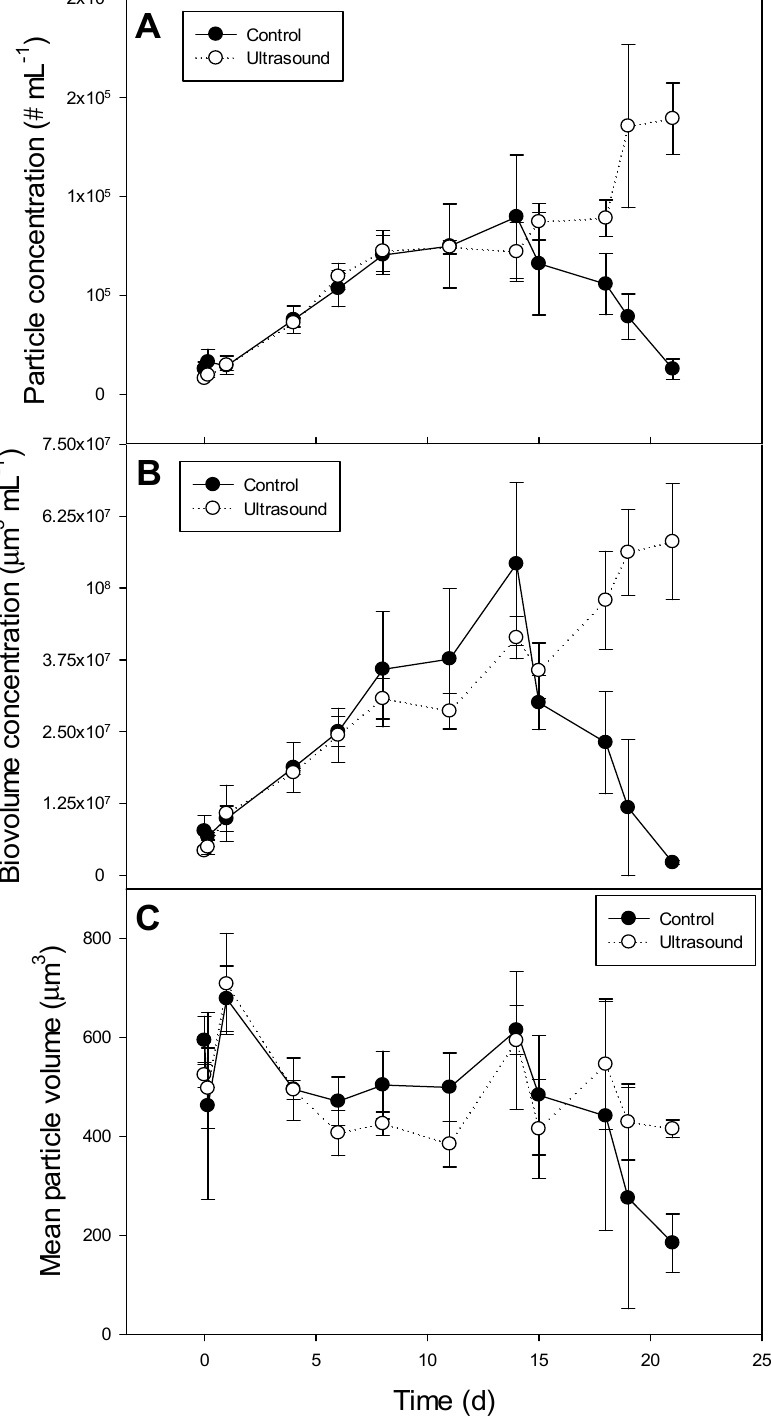
Figure 5. Course of particle concentrations (# mL − 1 ; panel A ), biovolume concentration (µm 3 ·mL − 1 ; panel B ) and mean particle volume (µm 3 ; panel C ) in plankton communities in 85 L tanks that were either non-exposed (control; solid circles) or exposed to ultrasound (open circles). Error bars indicate one standard deviation ( n =